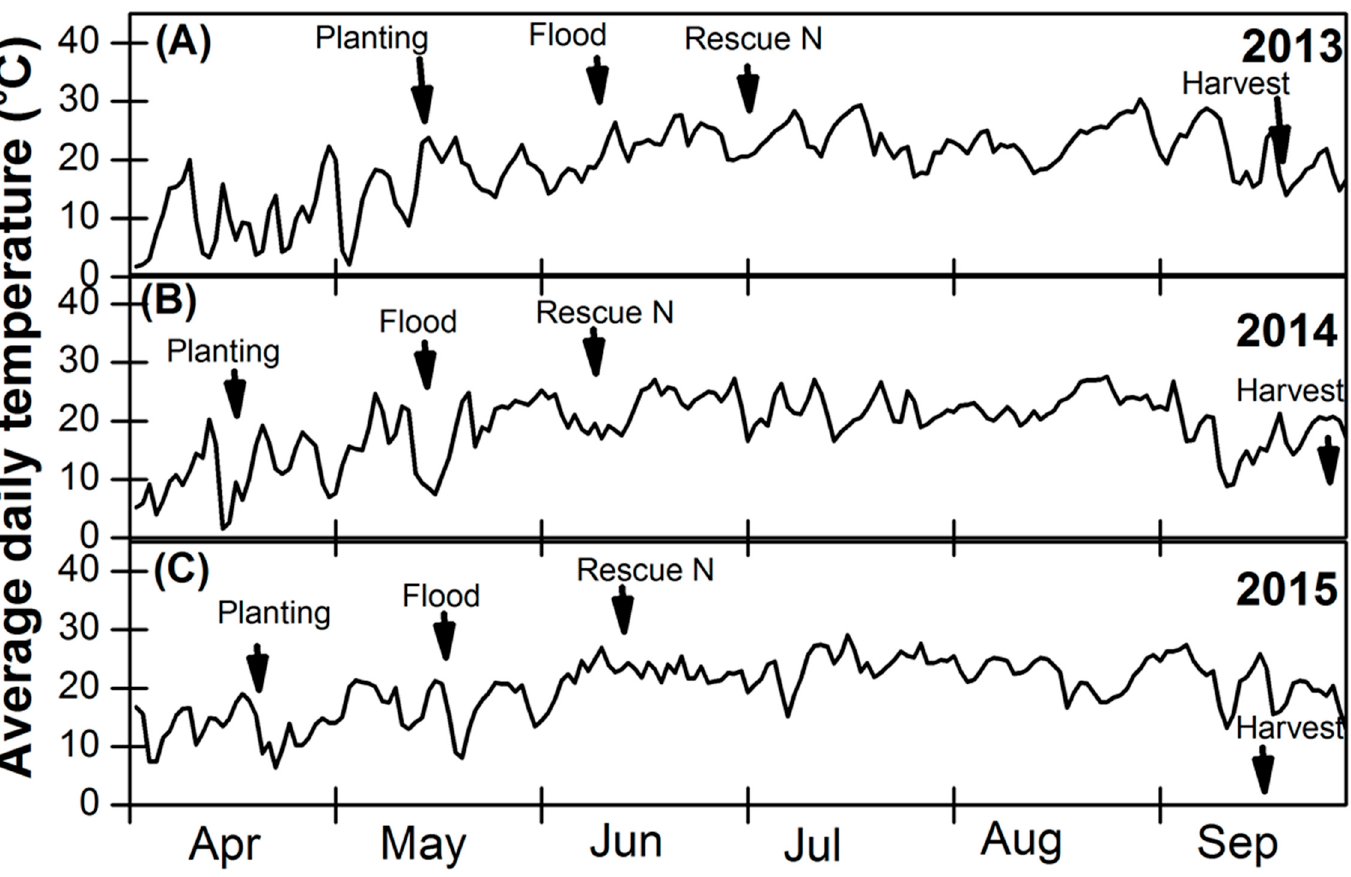
Figure 2. Average daily air temperature during the 2013 ( A ), 2014 ( B ) and 2015 ( C ) growing seasons. Arrows represent the timings of major field events. (Source: Kaur, Nelson and Motavalli [29]).